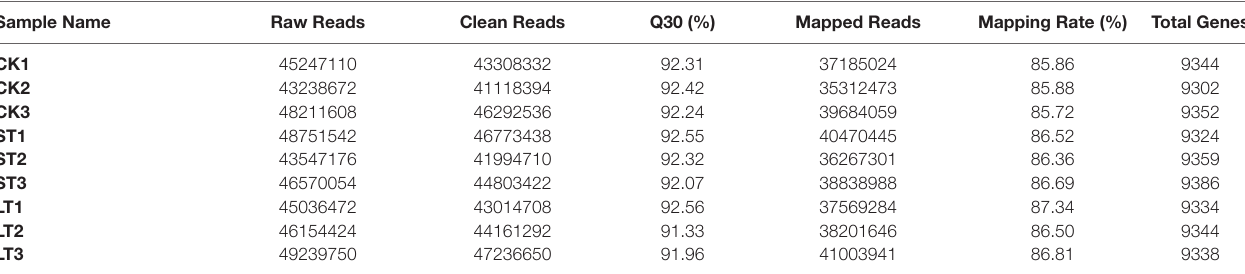
TABLE 4 | Summary statistics of the transcriptome of N. oceanica when subjected to different